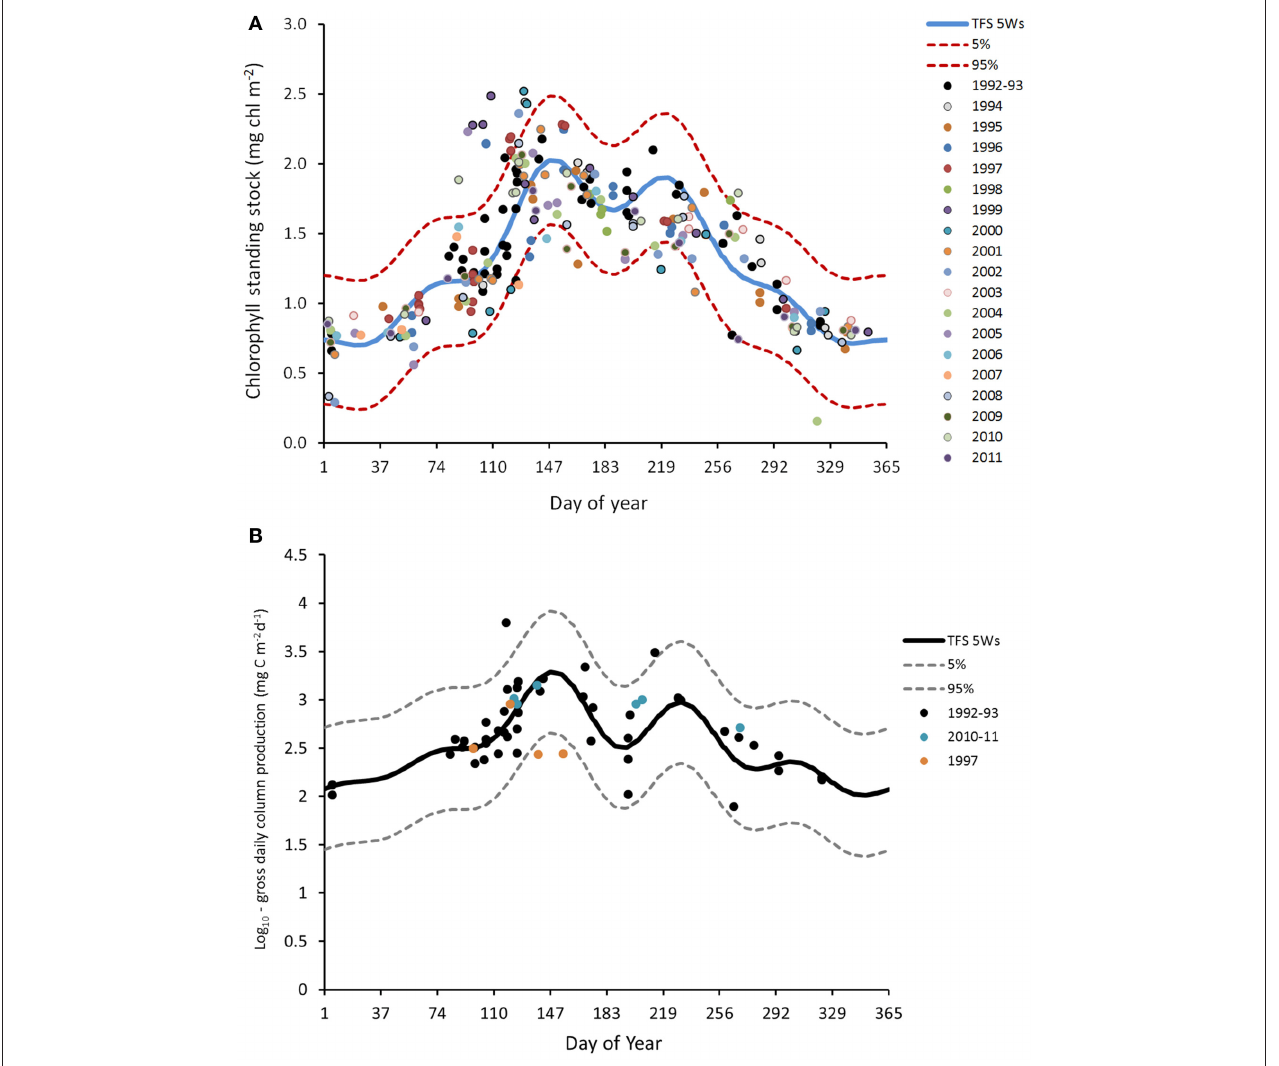
FIGURE 7 | Climatologies for column chlorophyll (mg m − 2 ) and gross primary production (mg C m − 2 d − 3 ) in the WIS, with fitted Truncated Fourier Series (TFS). (A) Chlorophyll concentrations at station 38/38A (1992–2011) were integrated over the euphotic zone (surface to euphotic depth) and are displayed on a log 10 scale. The blue line indicates the mean value of the TFS with 5 waves, the dotted lines above and below the mean value give the 5–95% ile envelope. (B) Column estimates of gross primary production calculated from light penetration and measurement of photosynthetic parameters, with similar TFS.